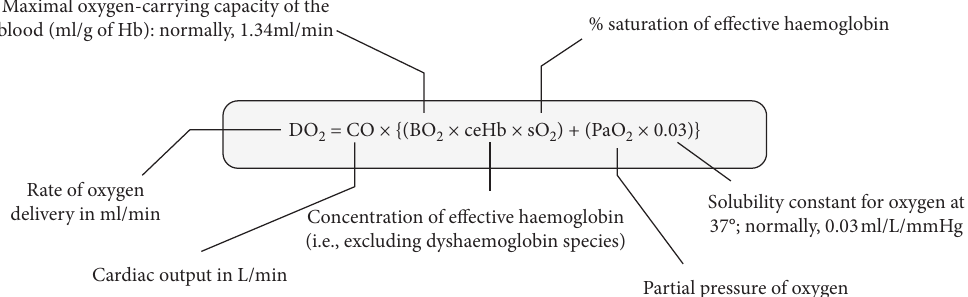
Figure 2: Rate of oxygen delivery and its relation to cardiac output and oxygen content of blood.